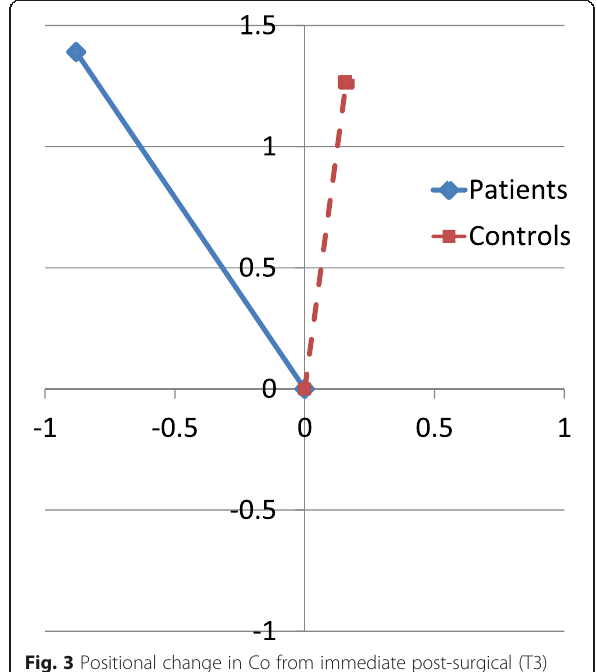
Fig. 3 Positional change in Co from immediate post-surgical (T3) plotted at (0,0) to follow-up exam